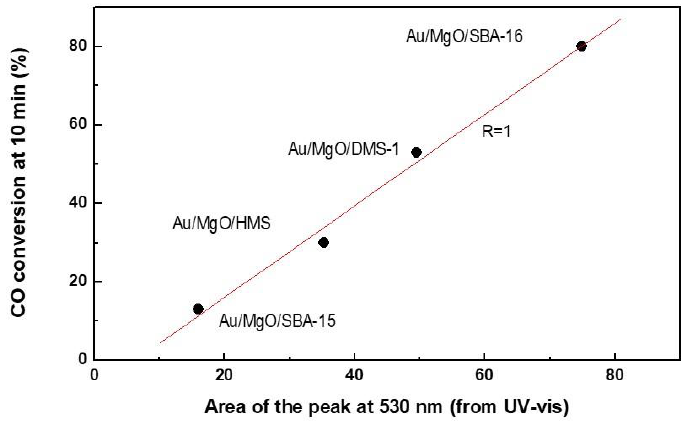
Figure 12. Influence of the surface Au 0 species (determined by DRIFTS-CO considering area of the peak at 530 nm) on the initial catalyst activity.